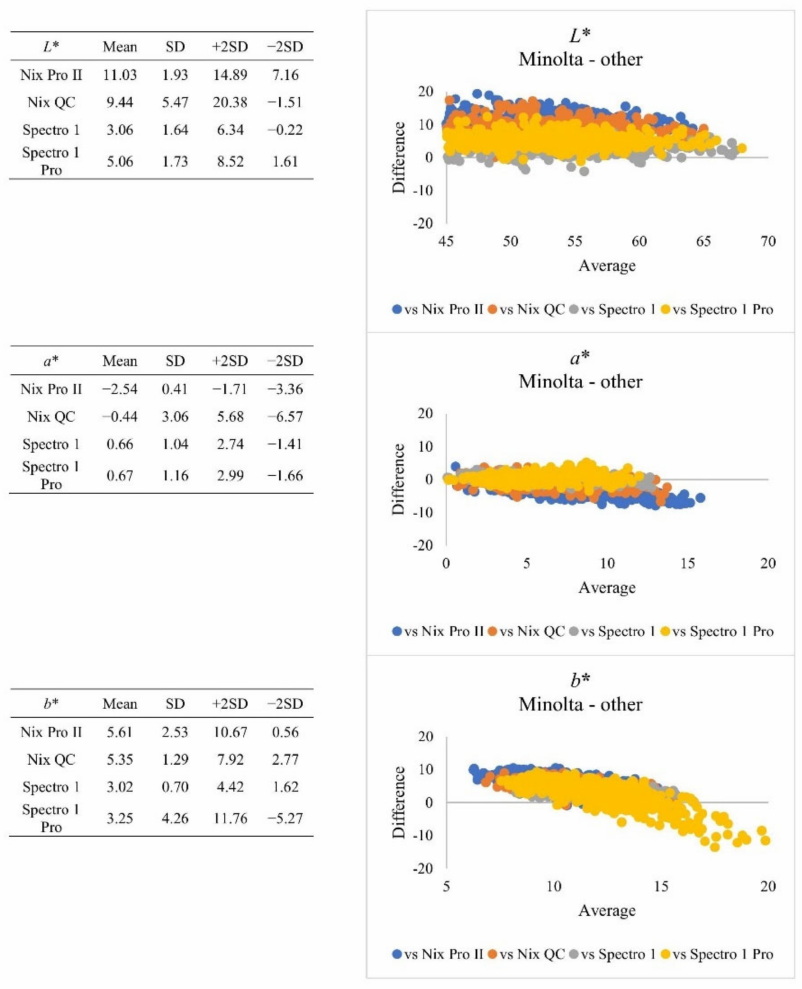
Figure 3. Plot of differences between Minolta and other instruments when retail meat samples were measured from central areas. SD = standard